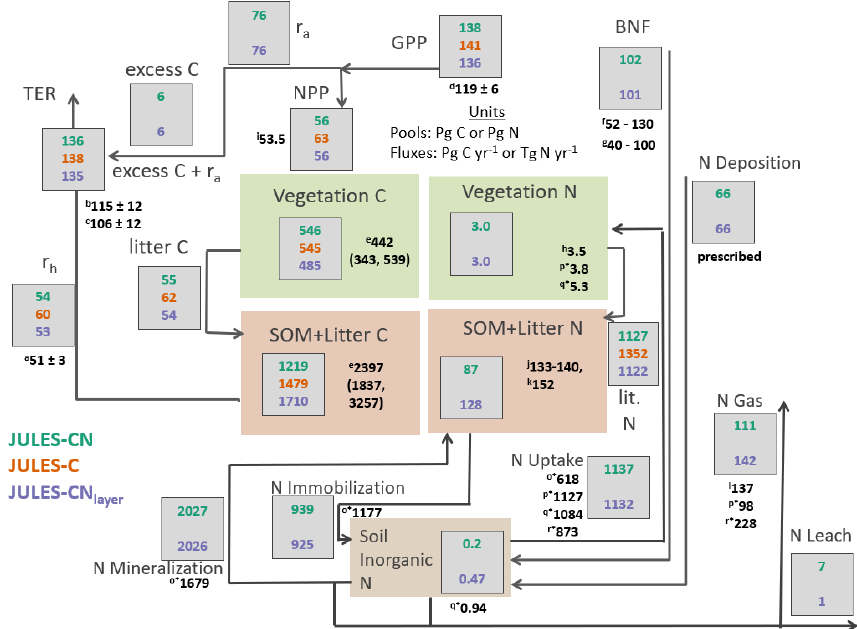
Figure 4. Carbon and nitrogen stocks and fluxes for JULES-CN, JULES-C, and JULES-CN layer for the period 1996–2005 (after Davies- Barnard et al. (2020)). C is carbon, N is nitrogen; r h is heterotrophic respiration, r a is autotrophic respiration, TER is total ecosystem respiration; GPP is gross primary productivity, NPP is net primary productivity, SOM is soil organic matter, BNF is biological N fixation, and N gas is the sum of N gas and N gasI , with N gasI representing approximately 90% of the total gas loss. The black numbers are the observation-constrained values from the literature, where observation-based values are not available JULES is compared with other global models: (a) heterotrophic respiration: Hashimoto et al. (2015); (b) TER: Li et al. (2018); (c) TER: Ballantyne et al. (2017); (d) GPP: Jung et al. (2011); (e) vegetation carbon and SOM+litter carbon: Carvalhais et al. (2014); (f) BNF Davies-Barnard and Friedlingstein (2020); (g) BNF Vitousek et al. (2013); (h) Vegetation nitrogen: Schlesinger (1997); (i) NPP: Zhao and Running (2010); (j) soil organic nitrogen: Batjes (2014); (k) soil organic nitrogen: Global Soil Data Task Group (2000); (l) nitrogen losses including nitrogen leaching: Gruber and Galloway (2008); (m) nitrogen leaching: Boyer et al. (2006); (n) nitrogen leaching: Galloway et al. (2004); (o*) organic nitrogen immobilisation and mineralisation and plant uptake von Bloh et al. (2018); (p*) nitrogen uptake, vegetation nitrogen, and nitrogen emissions Zaehle et al. (2010); (q*) nitrogen uptake and inorganic nitrogen content Xu-Ri and Prentice (2008); and (r*) nitrogen uptake and total nitrogen emissions